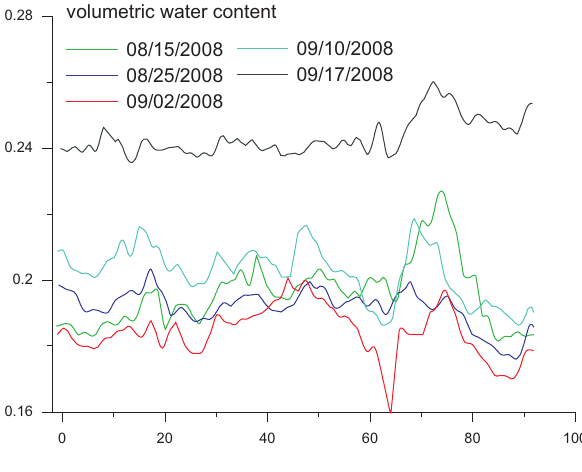
Fig. 7. Transect T1: average volumetric soil water content of the active layer over a distance of